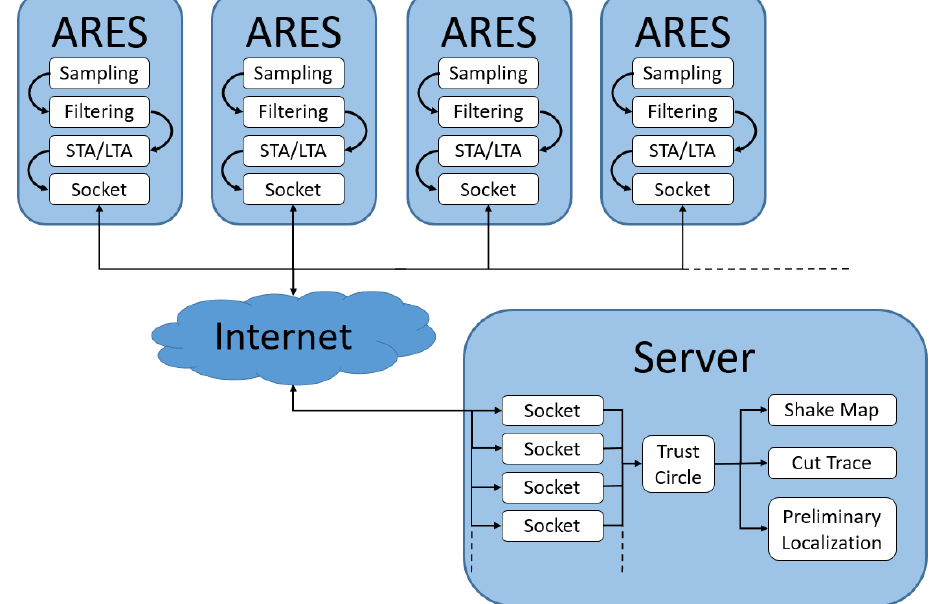
Figure 8. General scheme of the